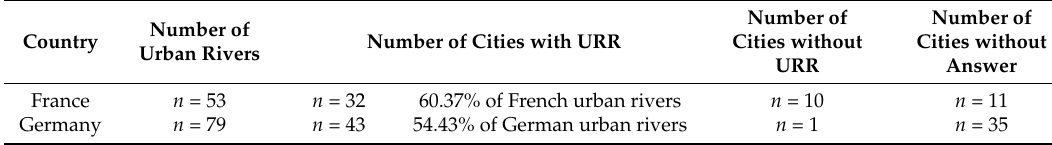
Table 1. Overview of the participation rate at the